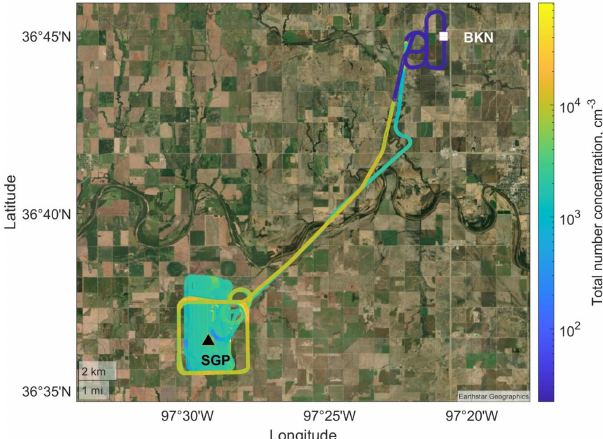
Figure 4. A typical flight track of one UAS flight (recorded on 13 November 2021) overlapped with the USGS national map. The UAS took off from Blackwell–Tonkawa Municipal Airport (BKN; white square) and sampled near the Central Facility (black triangle) of the SGP observatory. The flight track is colored with the total particle number concentration from an on-board CPC. Other sam- pling days used a partial version of this flight pattern due to weather limitations. Ground sampling occurred at the Central